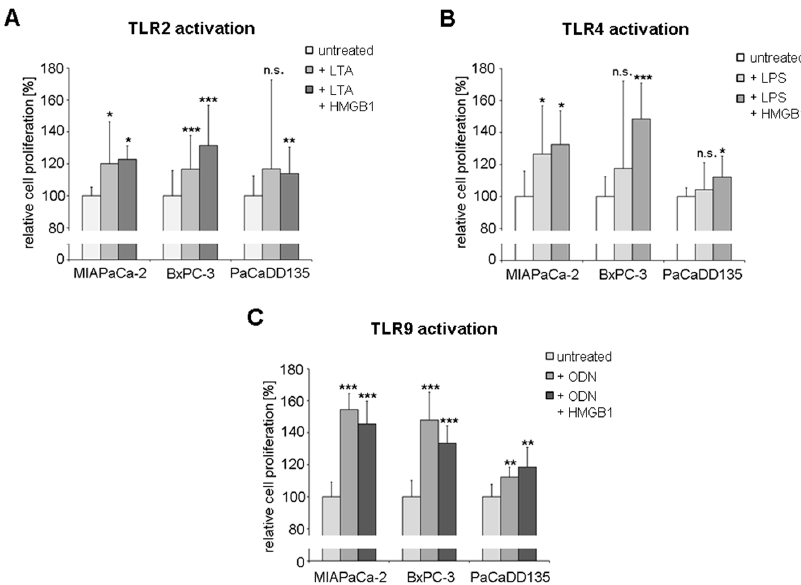
Figure 10. ATP proliferation assay of pancreatic cancer cell lines treated with TLR ligands. BxPC-3, MIAPaCa-2, and PaCaDD135 cells were incubated with: ( A ) LTA and LTA + HMGB1 (TLR2 activation); ( B ) LPS and LPS + HMGB1 (TLR4 activation); and ( C ) ODN and ODN + HMGB1 (TLR9 activation). Untreated cells were standardized to baseline. * p < 0.05, ** p < 0.005, *** p < 0.0001, n.s. not significant.